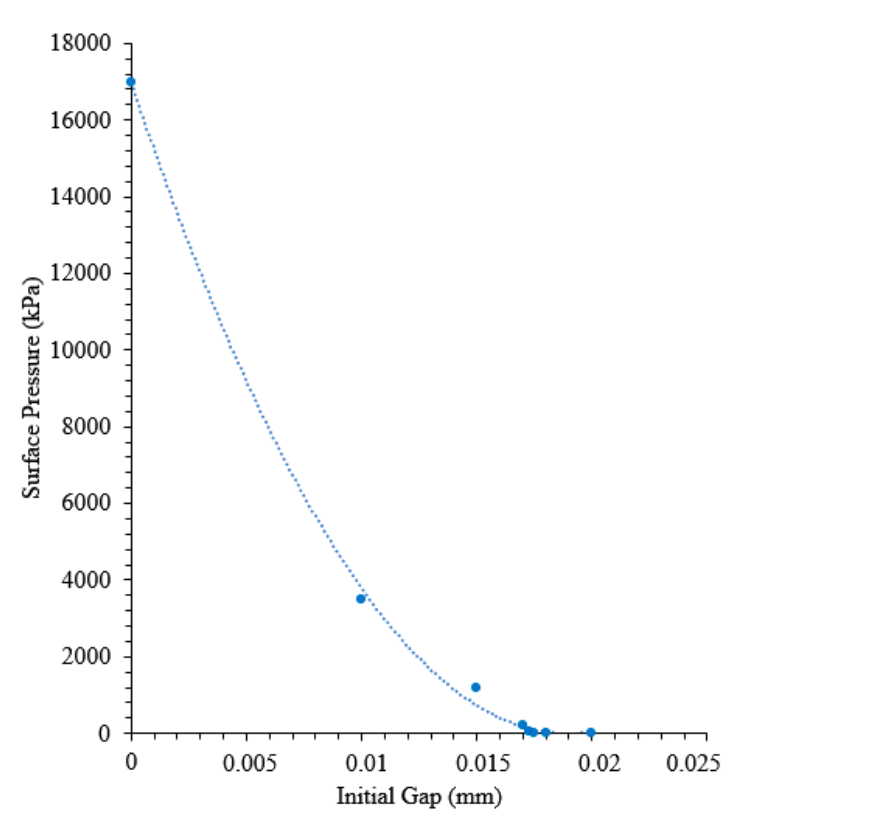
Figure 7. Rubber Surface Pressure (kPa) over time.